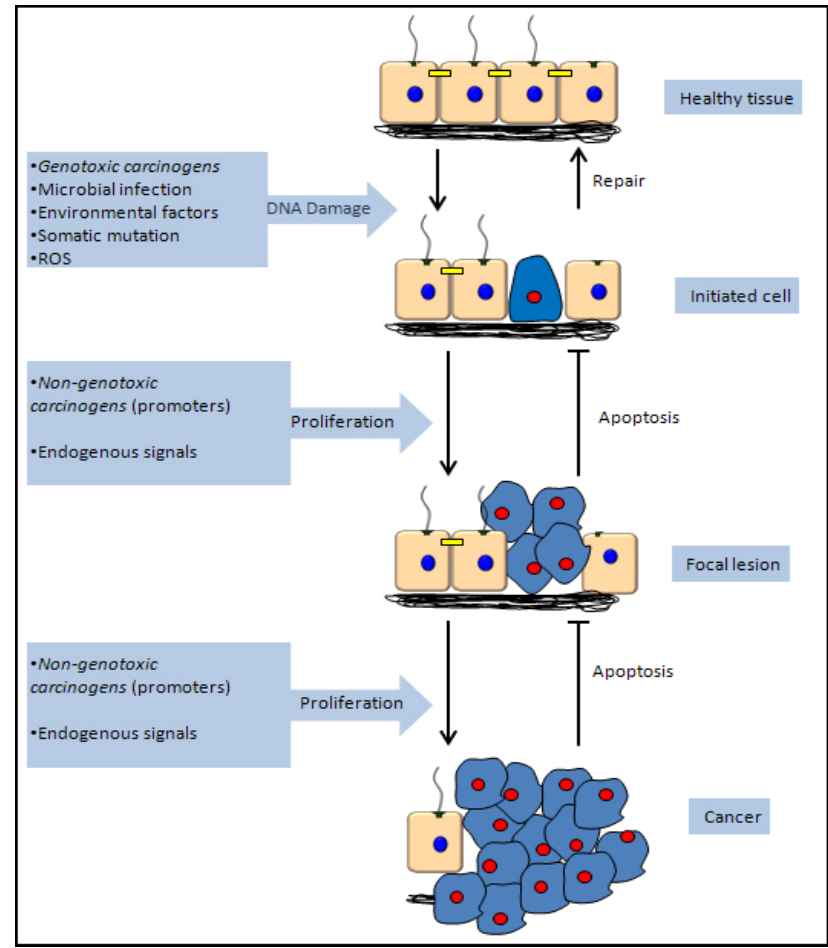
Figure 2. The role of the organic anion/cation transport system in